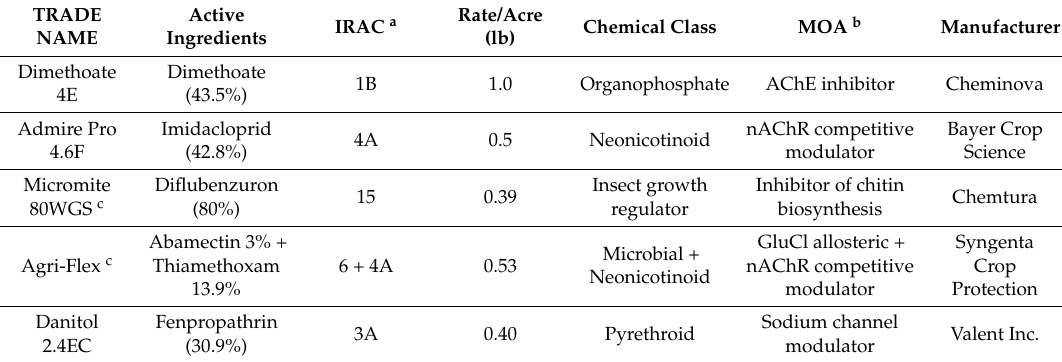
Table 1. Formulated insecticides evaluated as part of rotation modules for management of Asian citrus psyllid, Diaphorina citri .